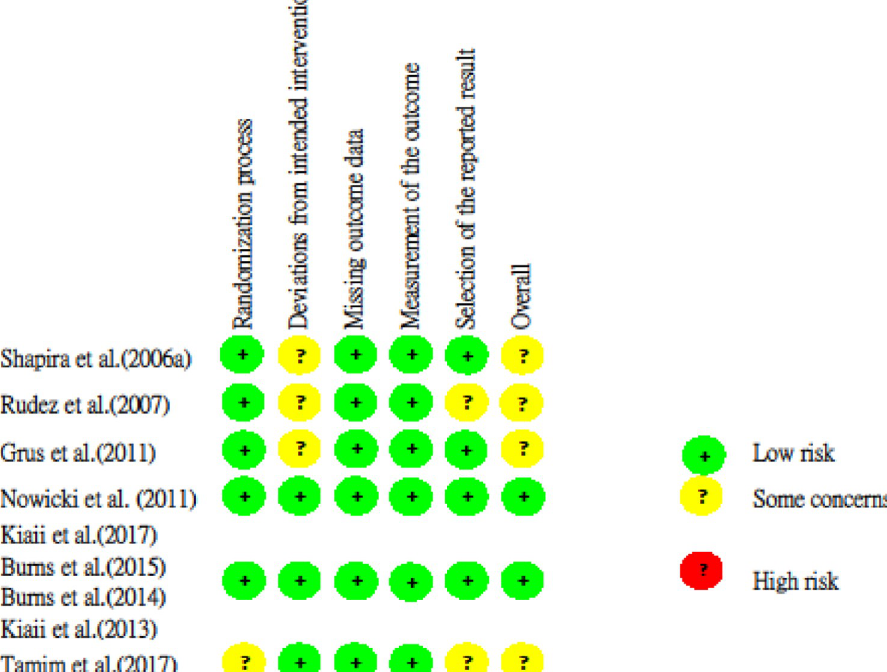
Fig 2. Risk of bias analysis for included Randomized Controlled Trials (RCTs).